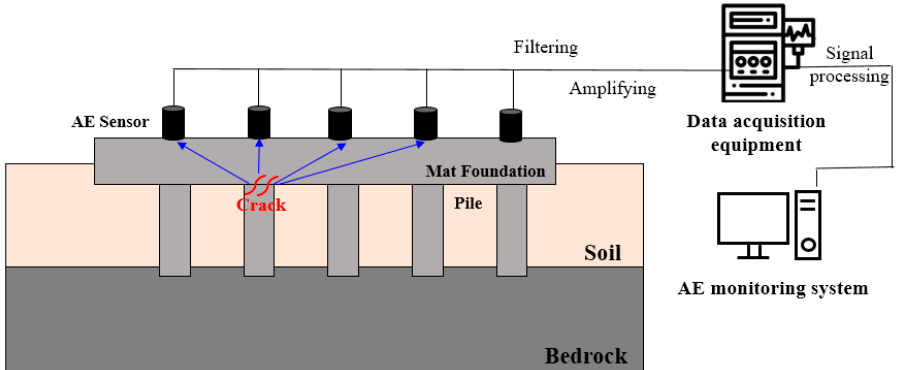
Figure 1. Schematic diagram of acoustic emission (AE) monitoring system for foundation structures.